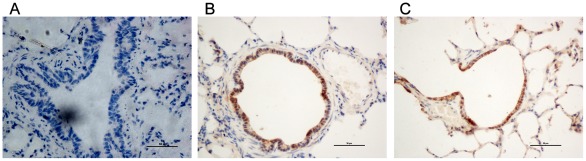
Immunohistochemical Staining of Lung Sections of Calves with M.bovis Infection.The lung tissues of calves from the negative control group (A), M. bovis HB0801- (B) and PG45-infected groups (C) were detected after immunohistochemical staining with monoclonal antibody to M. bovis. The positive cells were stained brown and the negative cells were counter-stained blue with hematoxylin. The positive cells were situated in bronchiole epithelia.